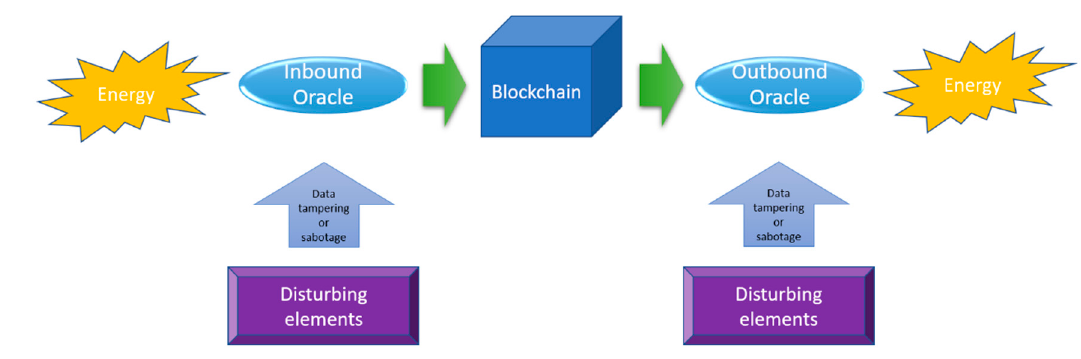
Figure 6. Example of the “dual” oracle problem.